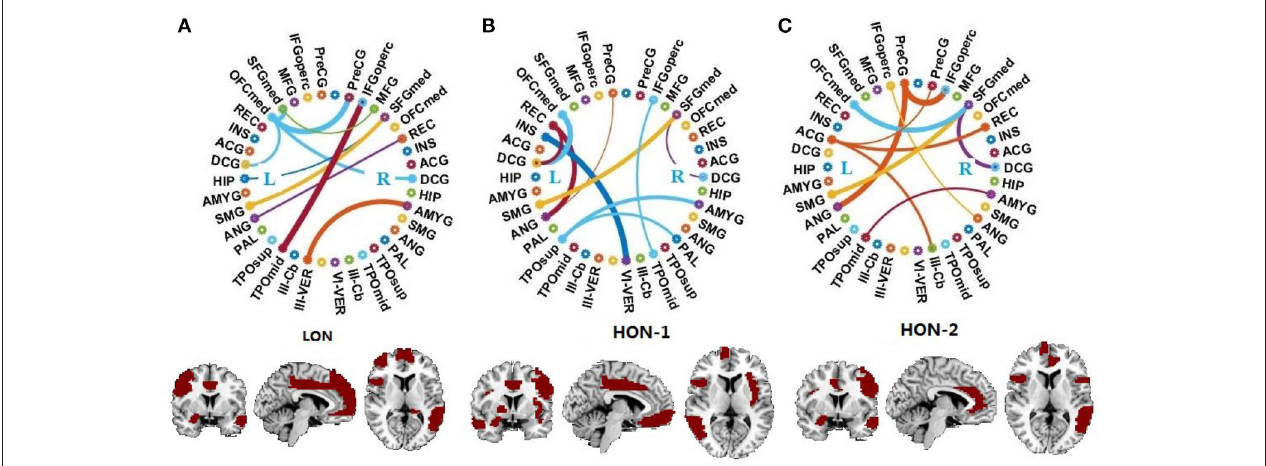
FIGURE 2 | Connectogram and involved brain regions of the top 10 discriminative connections selected by our framework in (A) the low-order FC network ( LON ), (B) the first-level high-order FC network (HON-1 ) and (C) the second-level high-order FC network (HON-2 ), respectively. The thickness of each line reflects its selection frequency, i.e., thicker lines indicate higher selection frequency. The brain slice view shows the involved brain regions (or ROIs). The brain slices were located at ( − 5, 4, 9) in the standard Montreal Neurological Institute (MNI) space. For the abbreviations of brain regions, please refer to Table 6 .